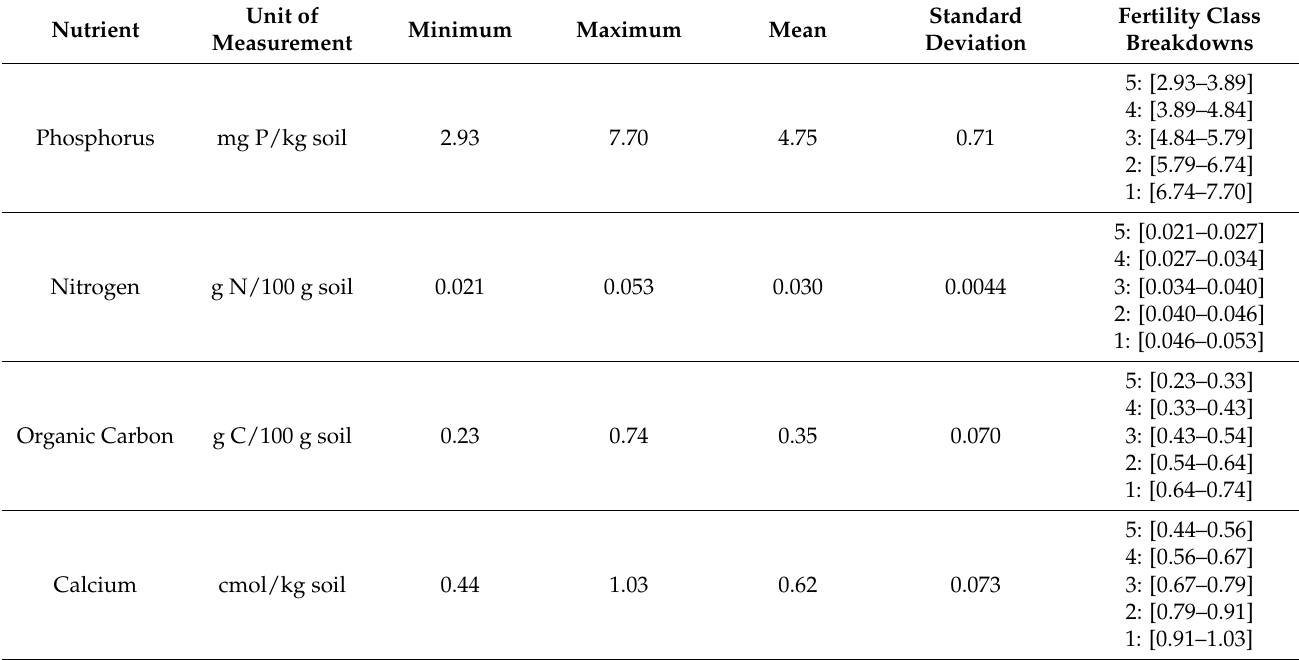
Table 11. Interpolated fertility statistics for the Dosso region of